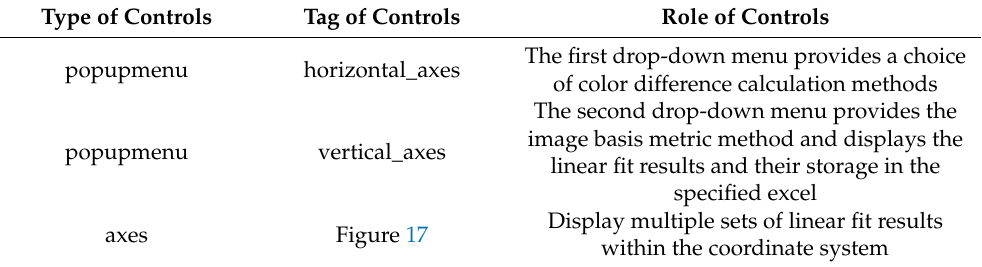
Table 8. Types, labels, and roles of controls used in the Module 8 interface. Type of Controls Tag of Controls Role of Controls